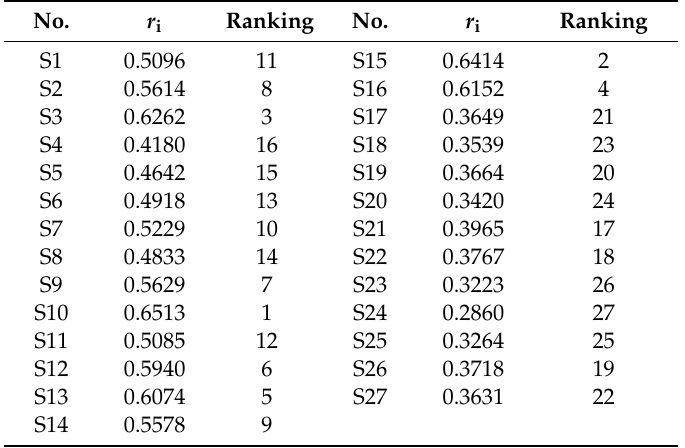
Table 2. Quality sequencing of Chuan maidong (CMD) and Zhe maidong (ZMD). No. r i Ranking No. r i